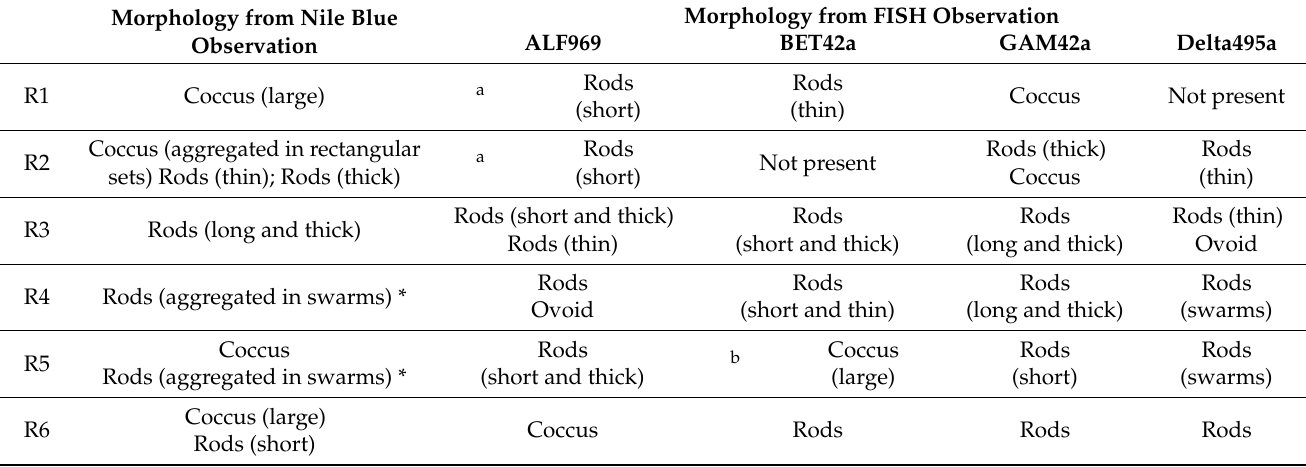
Table 5. Results from the microscopic observation of the real waste-fed cultures (R1 to R6) indicating the morphology of organisms with positive fluorescence signal under Nile blue staining (indication of possible PHA accumulators) and the most dominant morphology of bacteria from the Alphapro- teobacteria, Betaproteobacteria, Gammaproteobacteria and Deltaproteobacteria classes (observed through FISH).